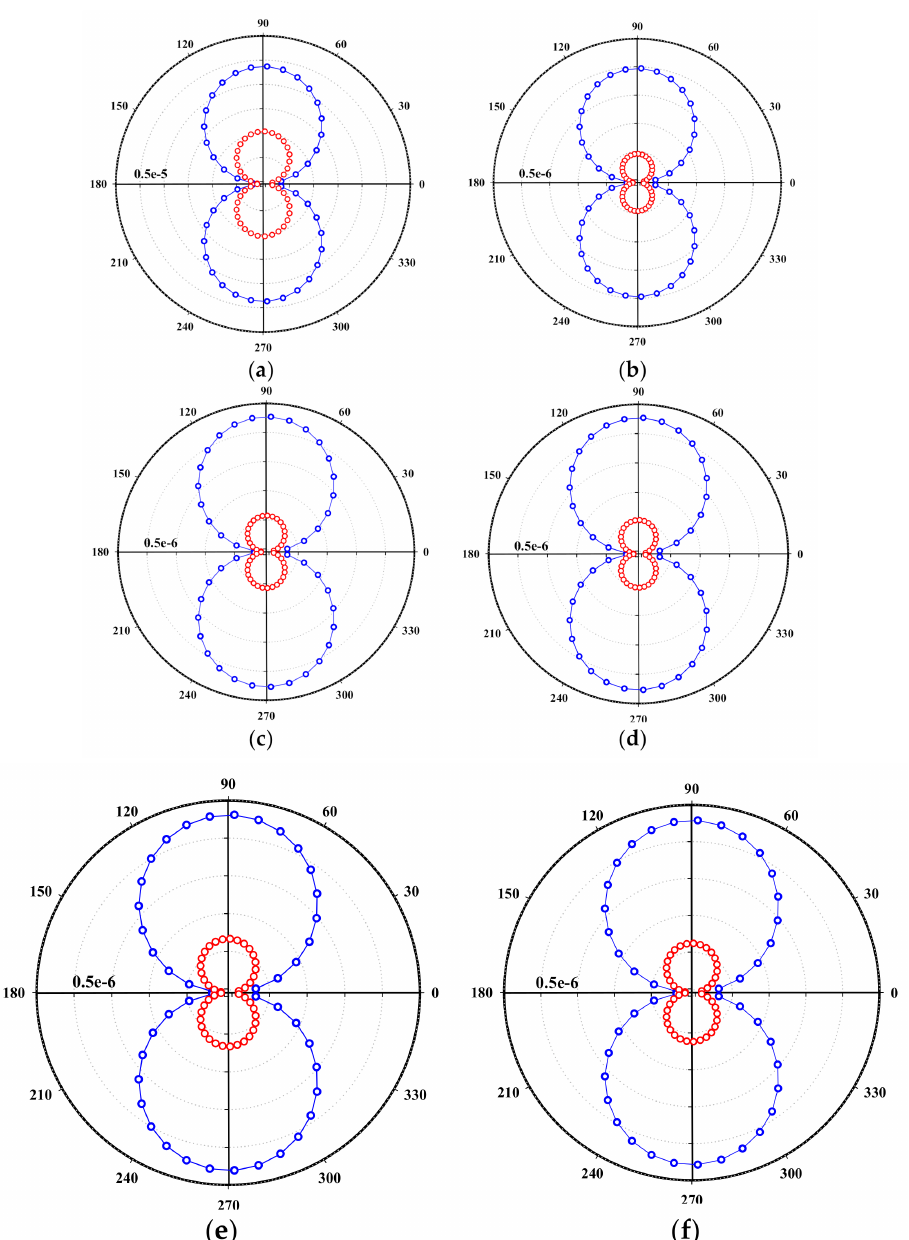
Figure 11. Directivity of root mean square SPL due to the fluctuation of lift (rod; red-solid line, Rod-Airfoil and airfoil; blue- solid line.): ( a ) A/C = 0, ( b ) A/C = 0.02, ( c ) A/C = 0.04, ( d ) A/C = 0.06, ( e ) A/C = 0.08, ( f ) A/C =